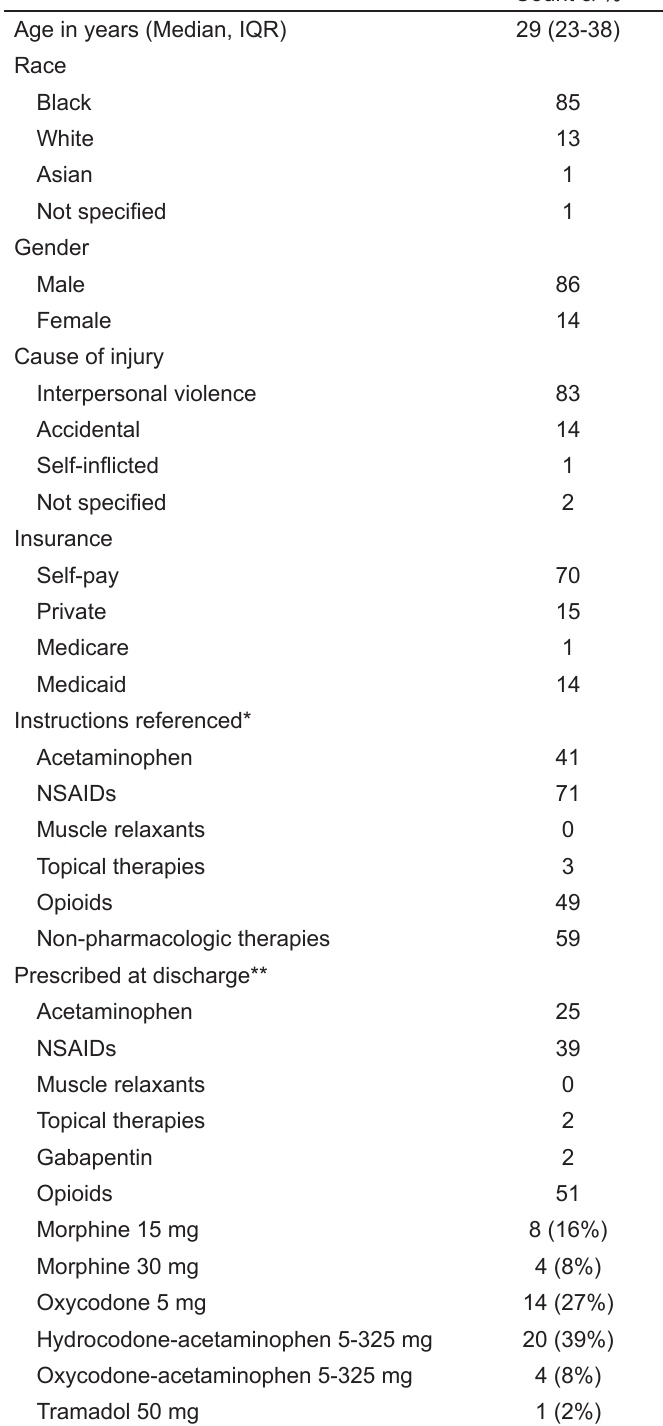
Table 2. Demographics, injury characteristics, and discharge pain medications provided to 100 patients discharged from the emergency department after bullet-related